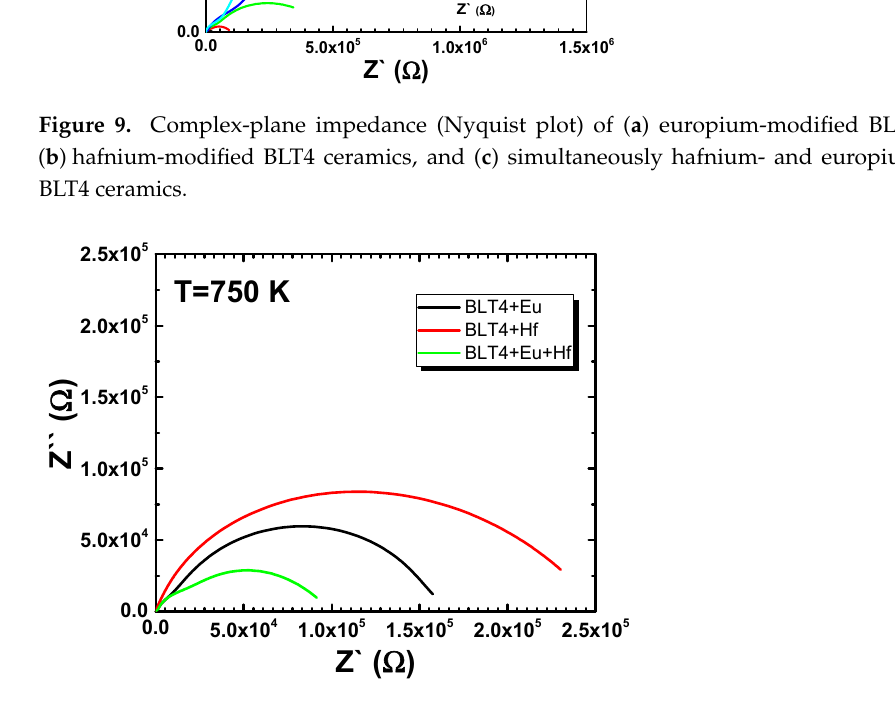
Figure 9. Complex-plane impedance (Nyquist plot) of ( a ) europium-modified BLT4 ceramics, ( b ) hafnium-modified BLT4 ceramics, and ( c ) simultaneously hafnium- and europium-modified BLT4 ceramics.